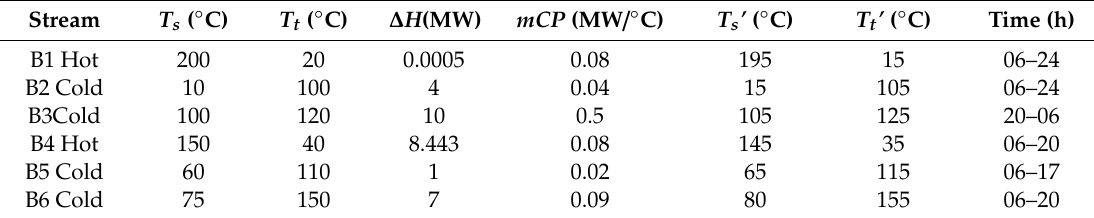
Δ = 20 °C (modified from Jamaluddin et al.